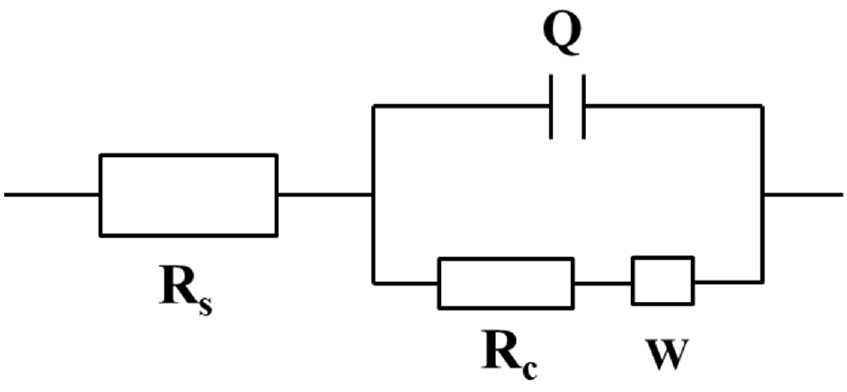
Figure 10. Equivalent circuit of the α -Fe 2 O 3 (u) coating and coating(x) (x = 4, 6, 8).